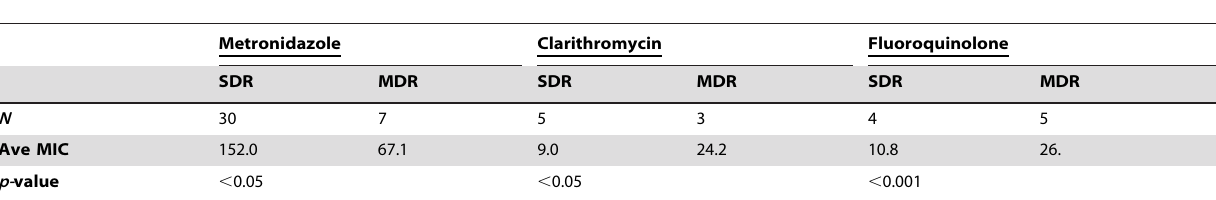
Table 3. Comparison of average minimum inhibitory concentration (MIC) between single-drug resistant (SDR) and MDR